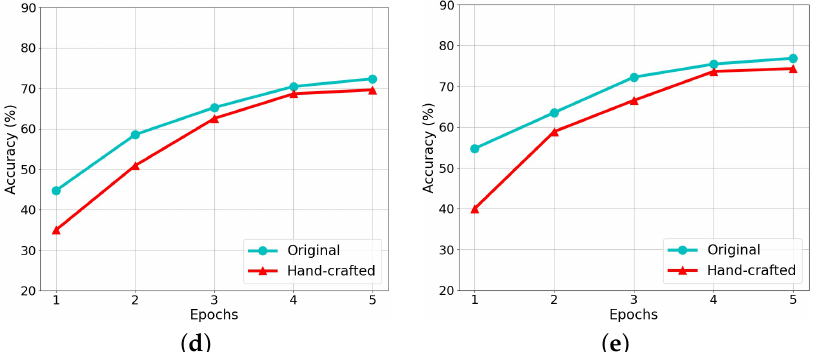
Figure 4. Model performance of our model and its variants per epoch on different corpora. ( a ) Ac- curacy on AFQMC. ( b ) Accuracy on OCNLI. ( c ) Accuracy on TNEWS. ( d ) Accuracy on INEWS. ( e ) Accuracy on BQ